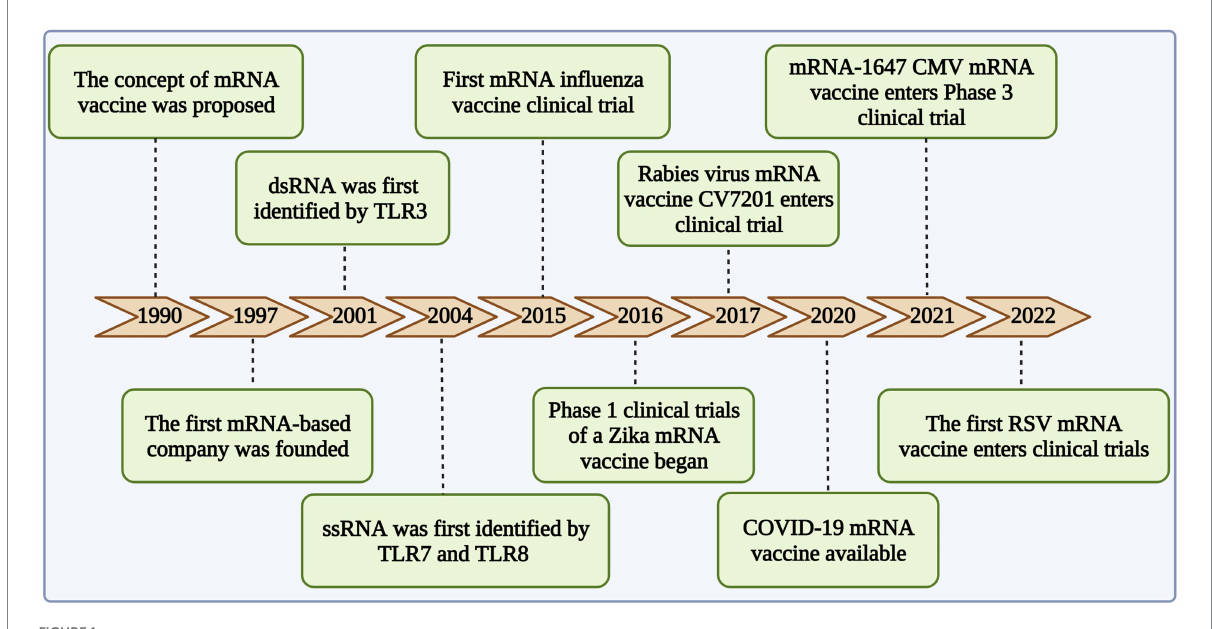
FIGURE 1 Development of mRNA vaccine in infectious